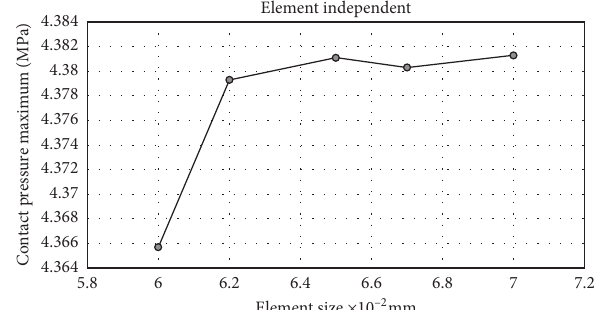
Figure 2: Element independence verification.